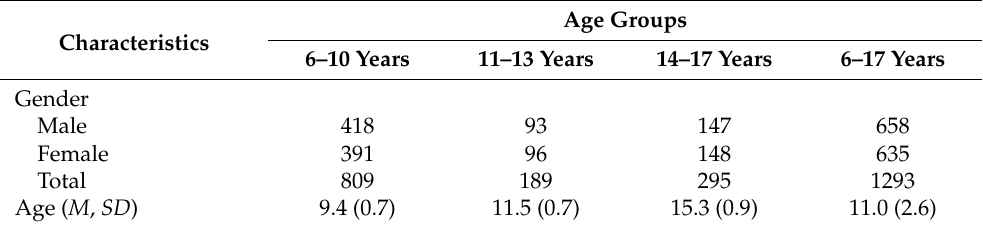
Table 1. Sample divided by age and gender.